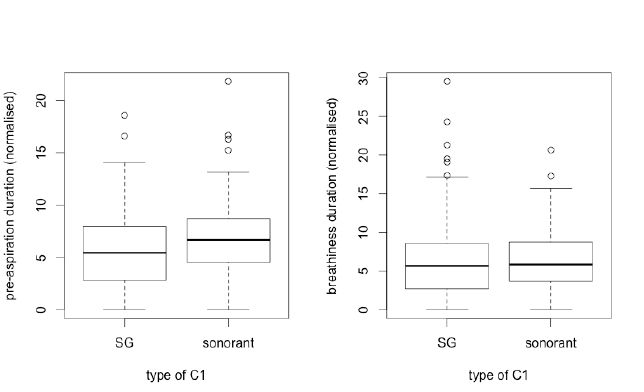
Figure 8: Normalised duration, for pre-aspiration (left) and breathiness (right), depend- ing on the type of C 1 ; context of long